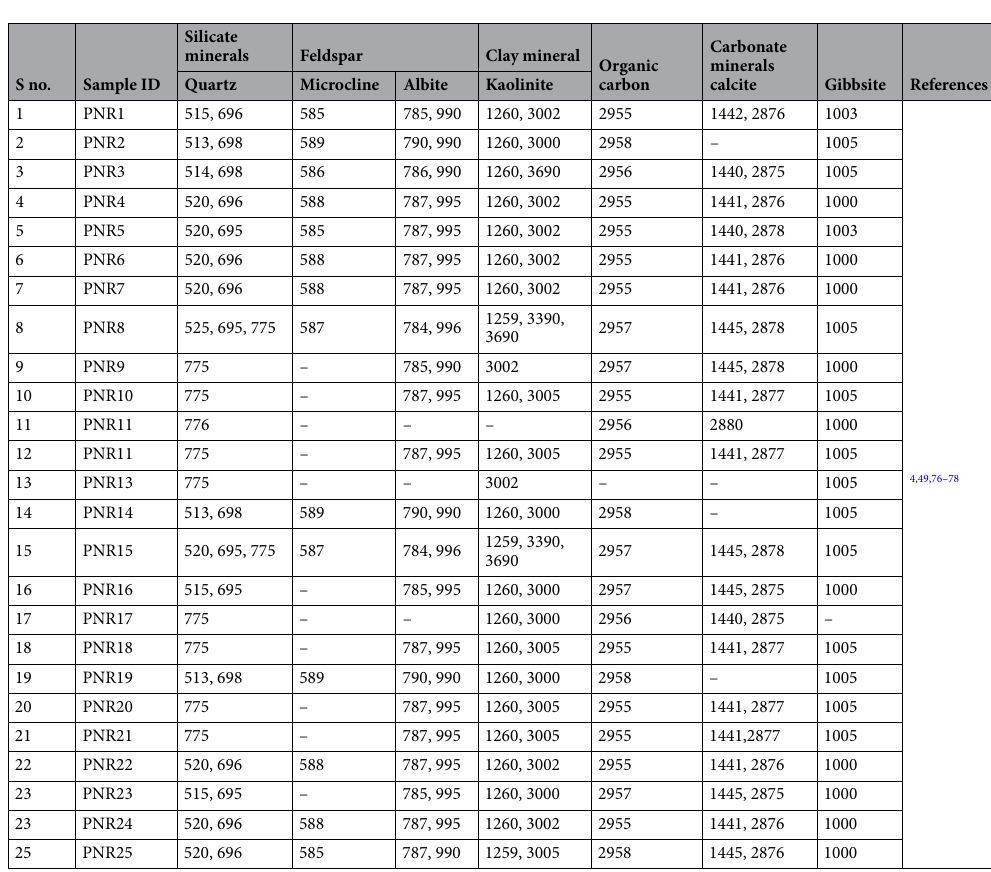
Table 3. Observed absorption frequency in the region 400–4000 cm −1 of sand samples with identified